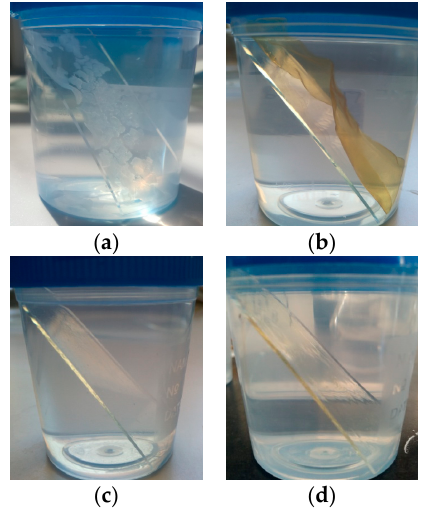
Figure 2. Photos of ( a , c ) Uncured C3 ‐ RT or ( b , d ) Cured C3 ‐ 120 polymeric coatings, after immersion in ultra ‐ pure water ( a , b ) or aqueous NaCl 1 M solution ( c , d ) for seven days.